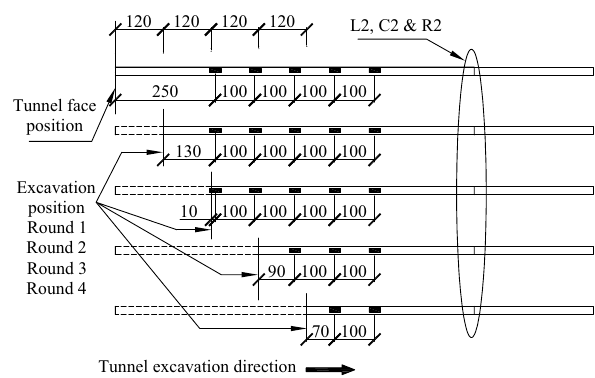
Figure 16. The relationship between the test points and excavation progress.